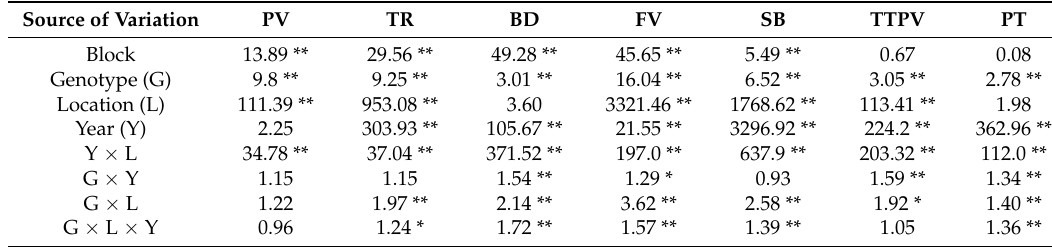
Table 2. ANOVA of different pasting properties.